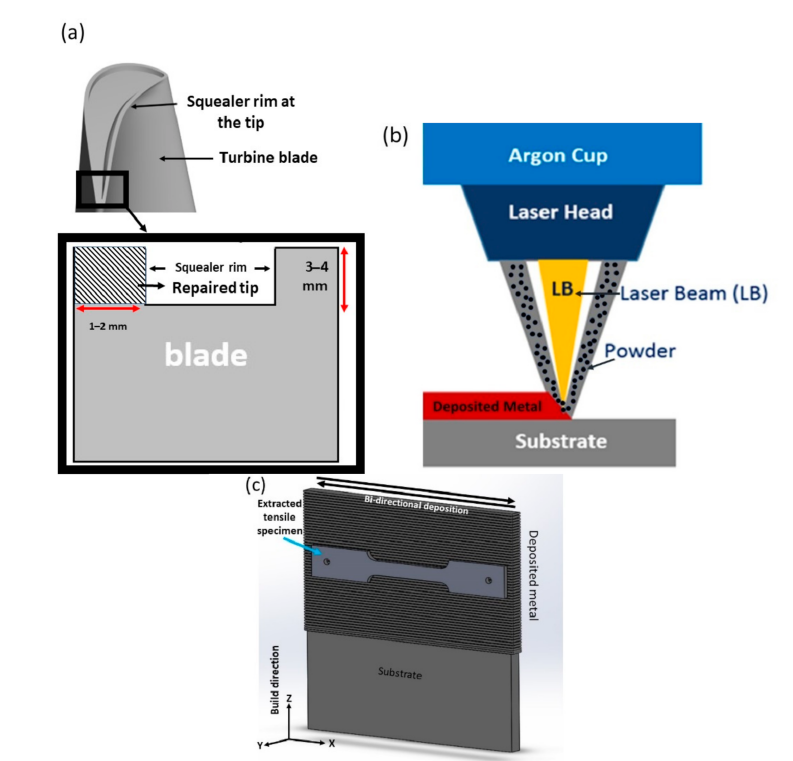
Figure 1. ( a ) Schematic of a typical turbine blade tip with a squealer rim, inset shows cross-section of the tip and hypothetically repaired squealer tip ( b ) schematic of LDED head with coaxial powder feeding, and ( c ) schematic of a bi-directionally deposited sample and orientation of extracted tensile specimen in respect to the build